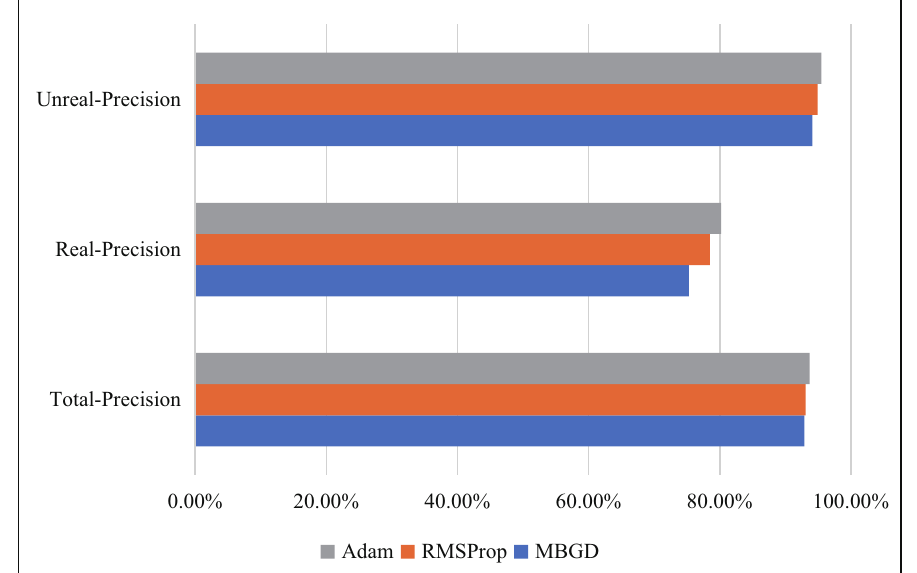
Figure 11. Comparison of experimental results with different optimizers.